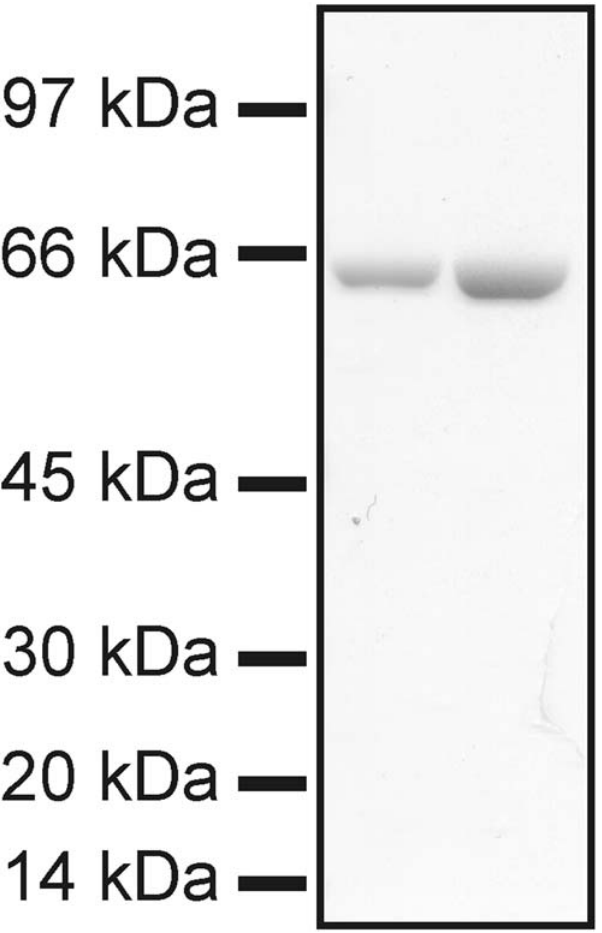
Figure 1. SDS-PAGE of VCC preparation. 0.5 and 1 m g (left and right lane respectively) of VCC, purified as described in Materials and Methods , were applied to SDS-PAGE and stained with Comassie-blue.